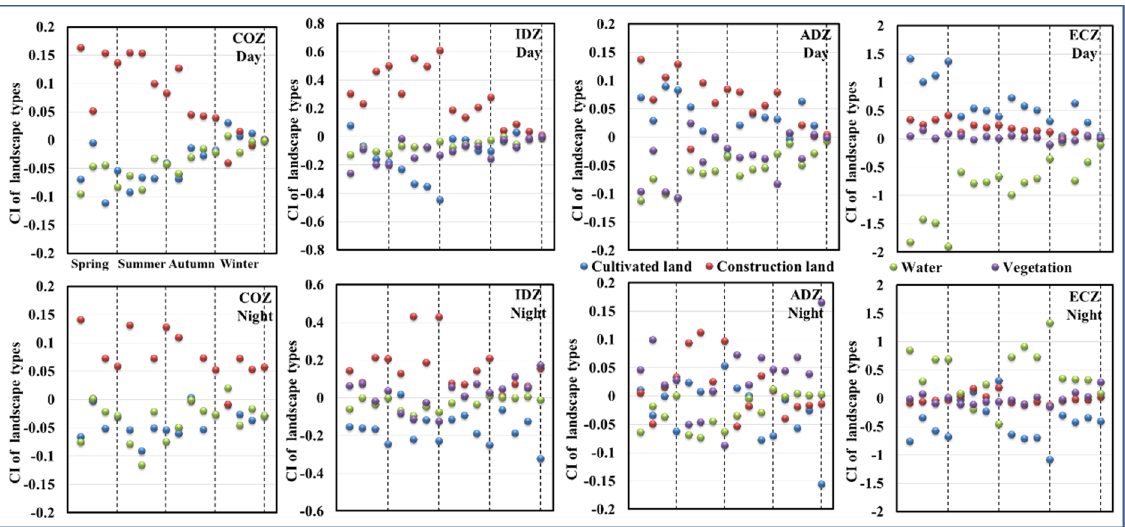
Figure 9. The CI of different landscape types under four MFOZs in 2011, 2014, 2017, and 2020 (There is almost no vegetation of 30 × 30 m in the COZ zone).